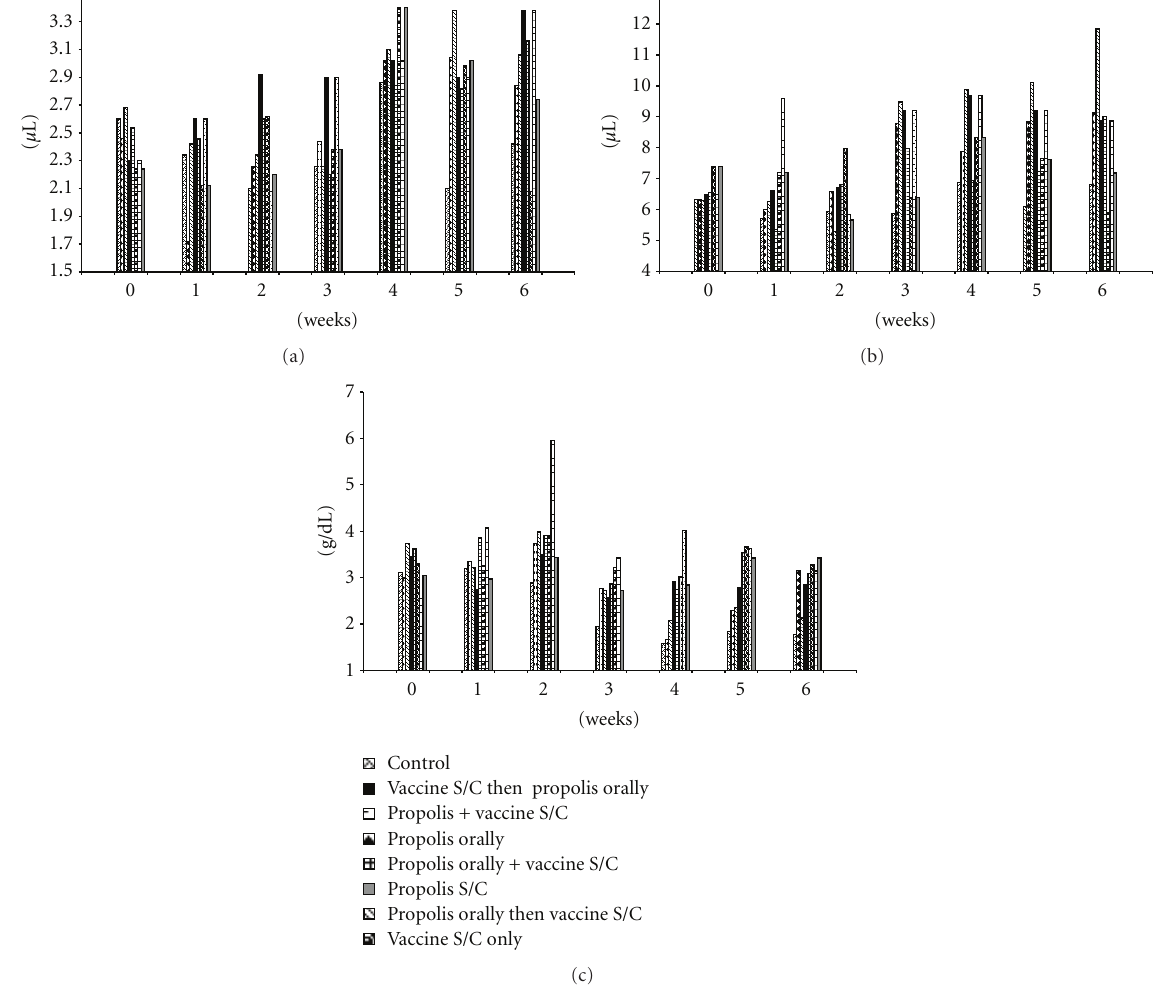
Figure 1: Heterophil (a), lymphocyte (b) counts, and serum globulins (c) in di ff erent experimental groups of rabbits received propolis and vaccine treatments for six